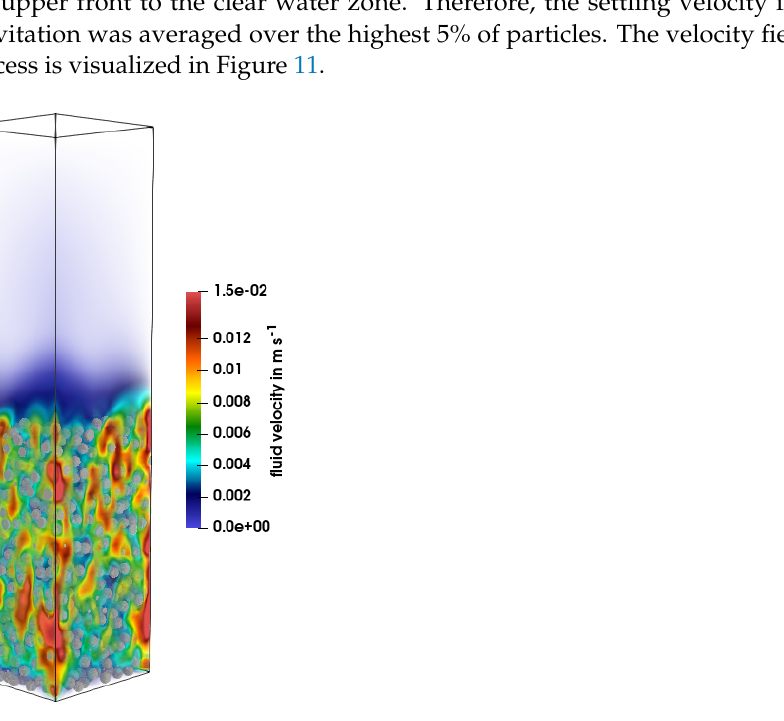
Figure 11. Velocity field around the sphere at t = 0.23s for the case of Re = 5.29 with a solid volume fraction of φ = 0.2.